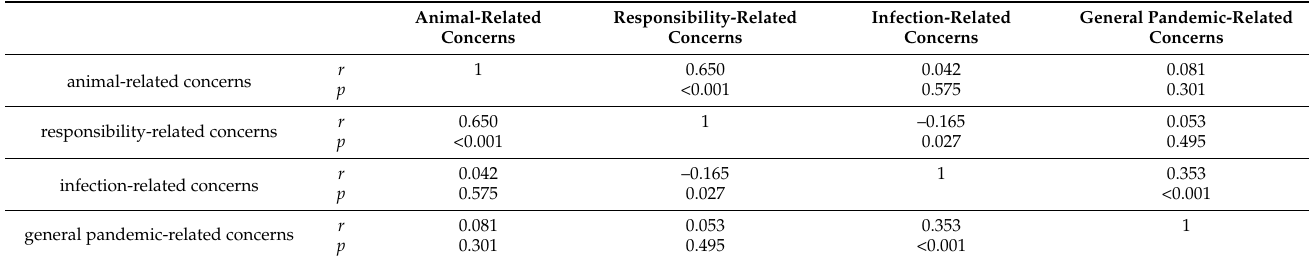
Figure 2. Mean values of pandemic-related concerns. Table 3. Correlations between pet-related and pandemic related